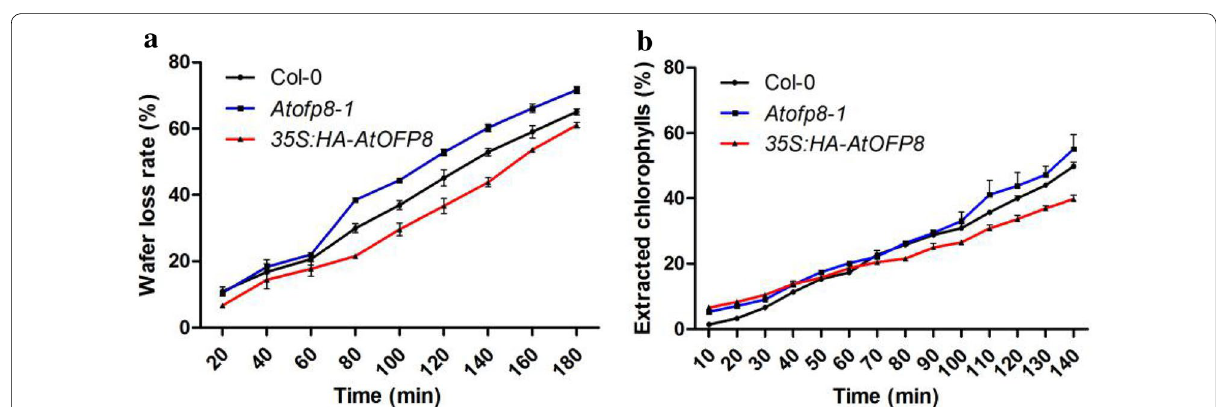
Fig. 7 Cuticular transpiration in Col‑0, Atofp8 ‑ 1 and 35S:HA ‑ AtOFP8 leaves. 5 weeks old leaves were used. Bars indicate SE of the mean. a Water loss assays. b Chlorophyll leaching